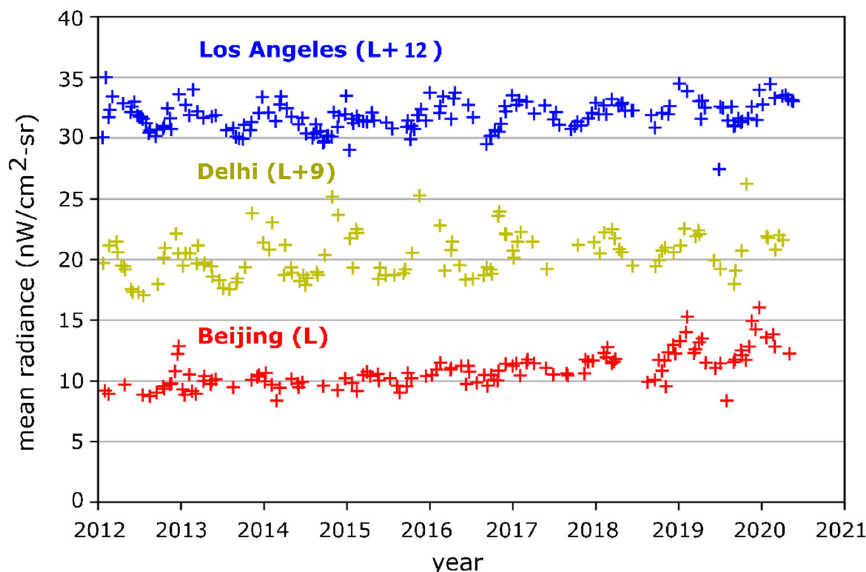
Figure 7. Urban night light mean radiance (L) time series (2012–2020) for Los Angeles [centered at: 34.05°N, 118.24°W] (blue: L + 12), Delhi [28.7°N, 77.1°E] (yellow, L + 9), and Beijing [39.9°N, 116.41°E] (red, L). Each data point in the plot is the mean radiance value within the AOI calculated from the VIIRS/DNB image for that day.